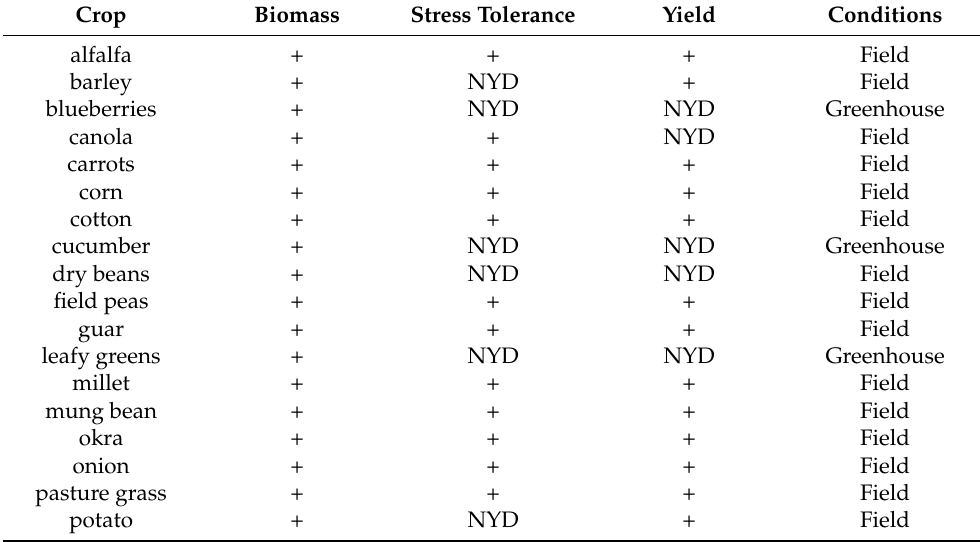
Table 5. Crop Responses to ThSM3a.